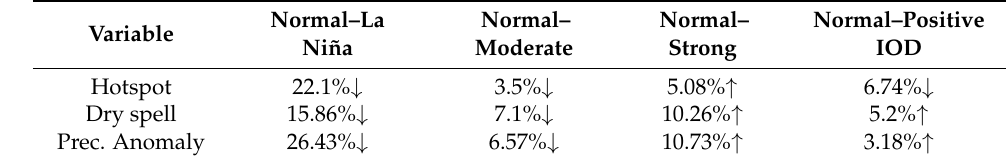
Table 3. Cambodia—difference value of the PDF from years categories.